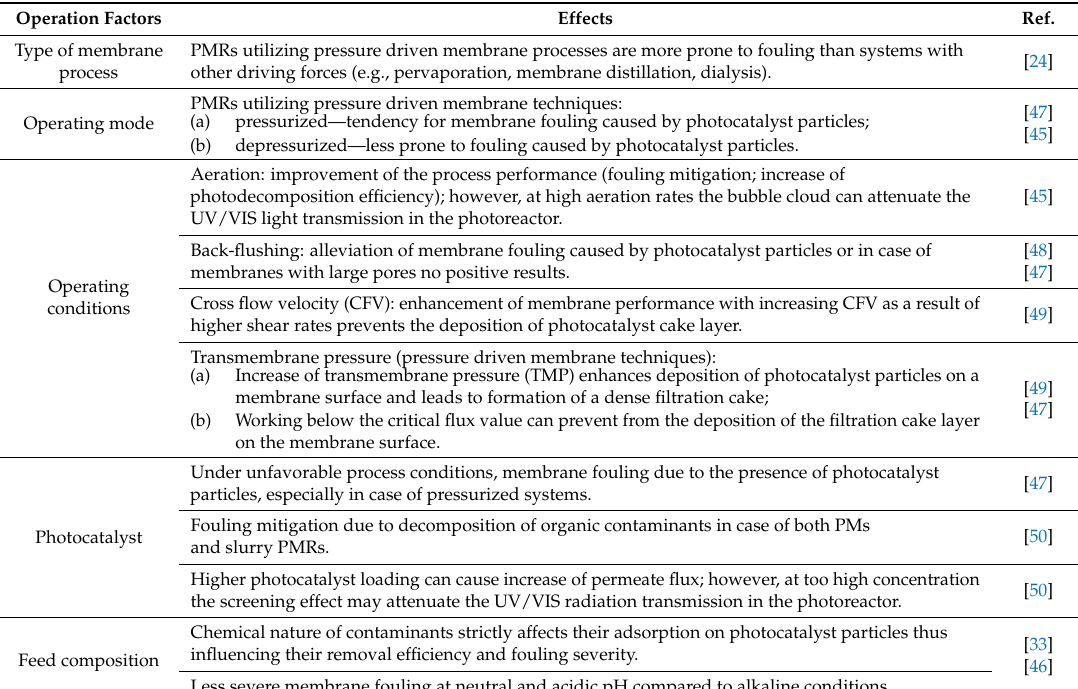
Table 1. The influence of various operation parameters on PMRs